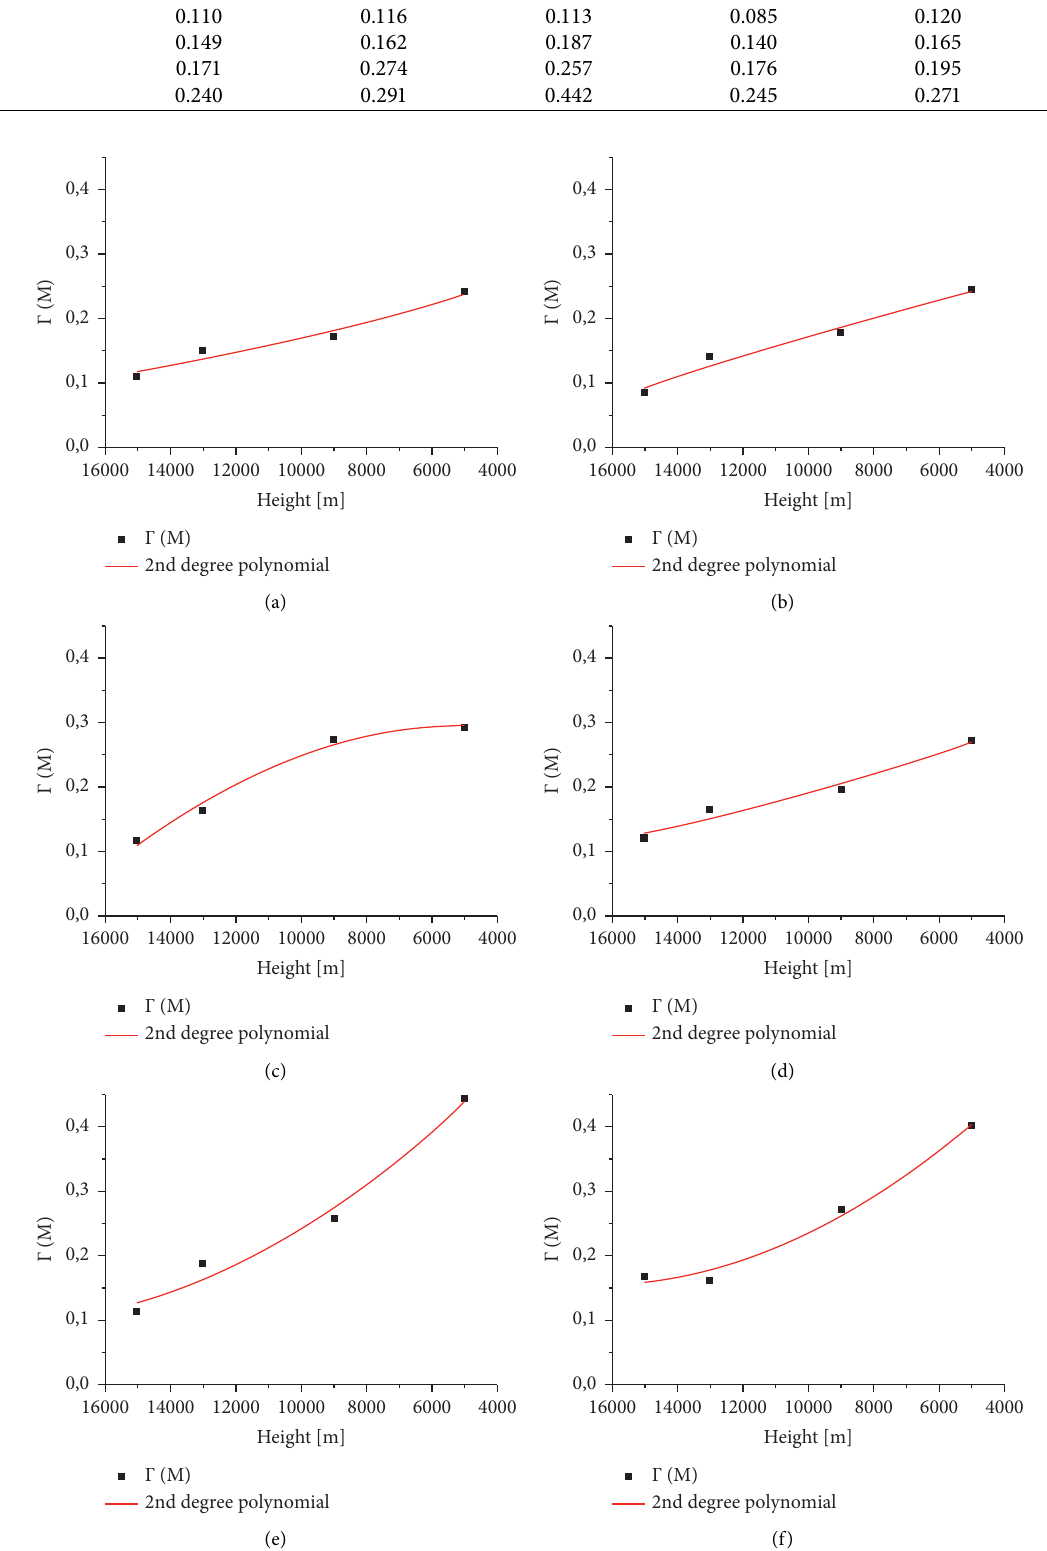
Figure 10: Dependence of drag coefficient on altitude change for fragment of meteorite Koˇsice with catalog no. 53 (23.2 g). The graph shows the increasing value of the drag coefficient Γ when changing the altitude. (a) X . (b) IX . (c) Y . (d) IY . (e) Z . (f) IZ .